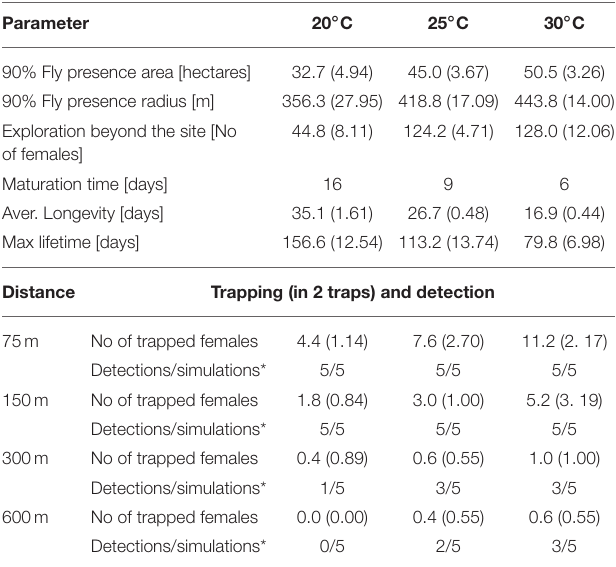
* The table contains averages of 5 simulations/replicates, and SD (provided in parentheses).